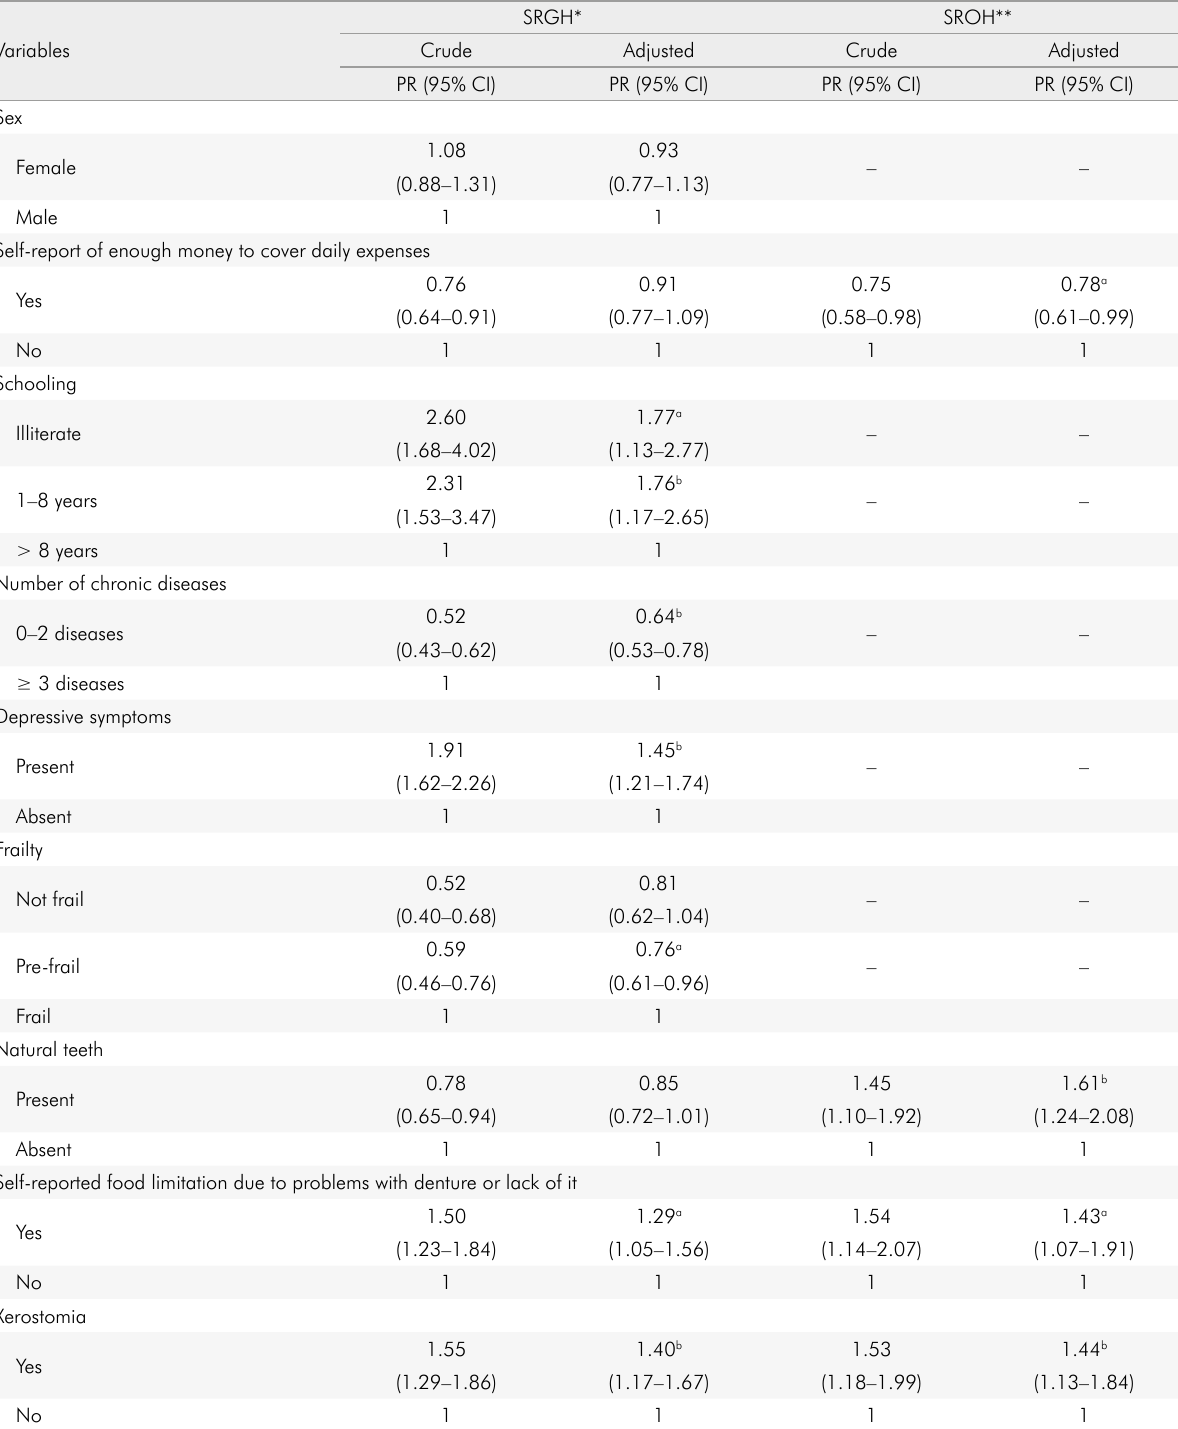
Table 2. Crude and adjusted prevalence ratios and 95% confidence intervals (CI) of the variables associated with SRGH and SROH.